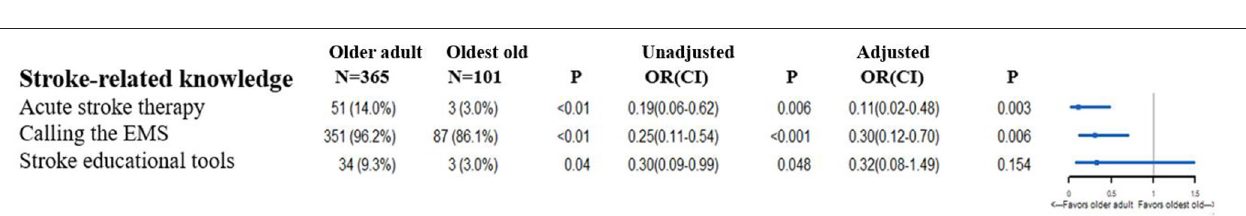
FIGURE 1 | Differences in the knowledge of stroke symptoms and risk factors between older adults and the oldest old. OR, Odds Ratio; CI, Confidence Interval. In the multivariable logistic regression analysis, we adjusted gender, educational background, smoking history, drinking habit, hypertension, diabetes, myocardial infarction, prior stroke, dyslipidemia, cancer history, atrial fibrillation. The OR means the comparison between the older adults and oldest old (oldest old vs. the older adults).